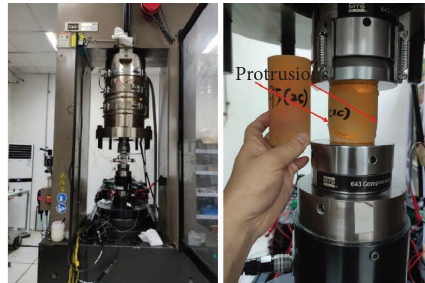
Figure 9: UCS tests on an MTS815